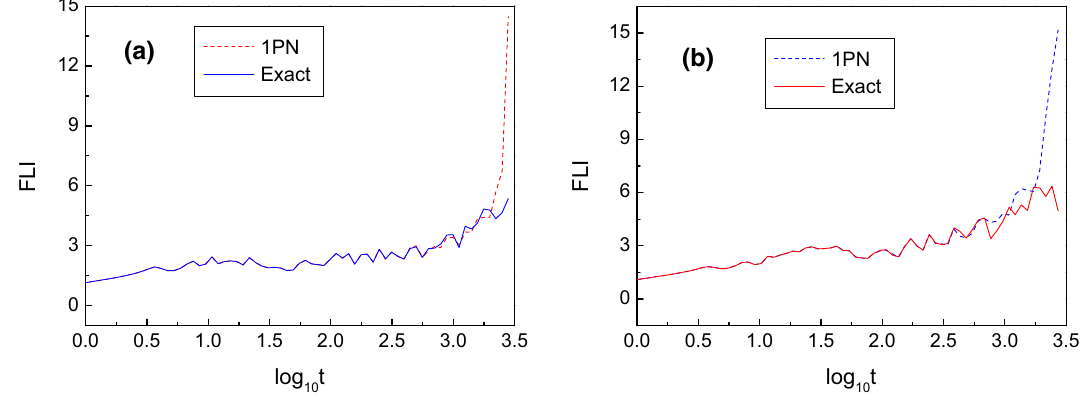
Fig. 9 FLIs of orbits in the two systems with different parameters: a Orbit 1 with c = 44 . 67; b Orbit 3 with c = 50 .